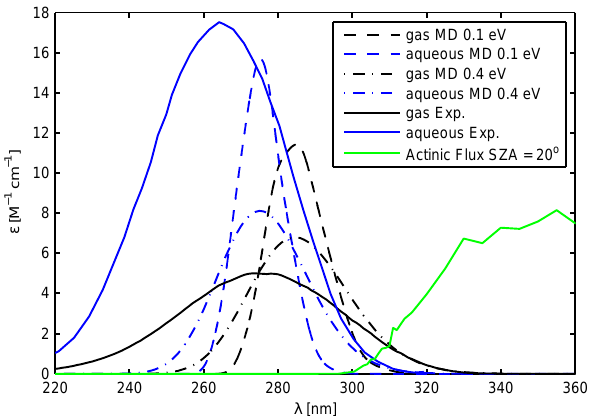
Fig. 7. Comparison of published aqueous- (Xu et al., 1993) and gas- phase acetone spectra (Sander et al., 2011) with spectra calculated using MD simulations. Gas and aqueous absorption cross sections were calculated with a 0.1eV and 0.4eV Gaussian broadening. The solar actinic flux at a solar zenith angle of 20 ◦ is also shown for